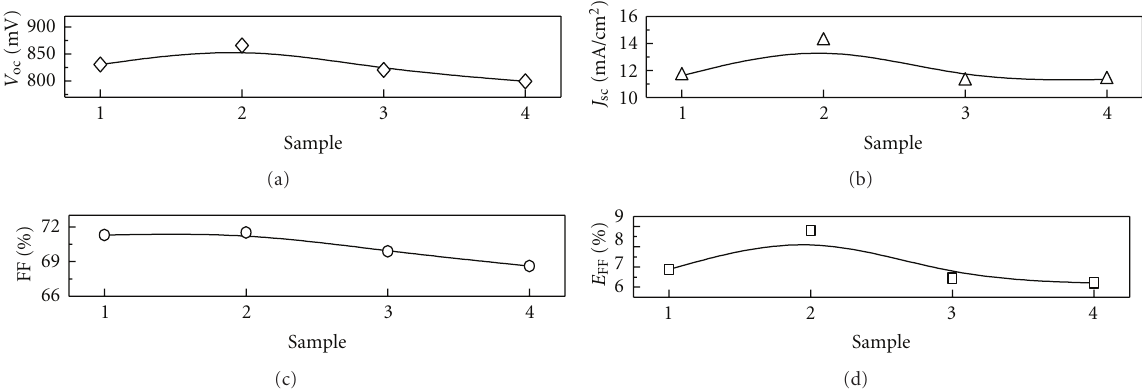
Figure 4: Solar cell parameters measured under AM 1.5 illumination conditions of thin film solar cells, with p-layer having di ff erent doping ratio.